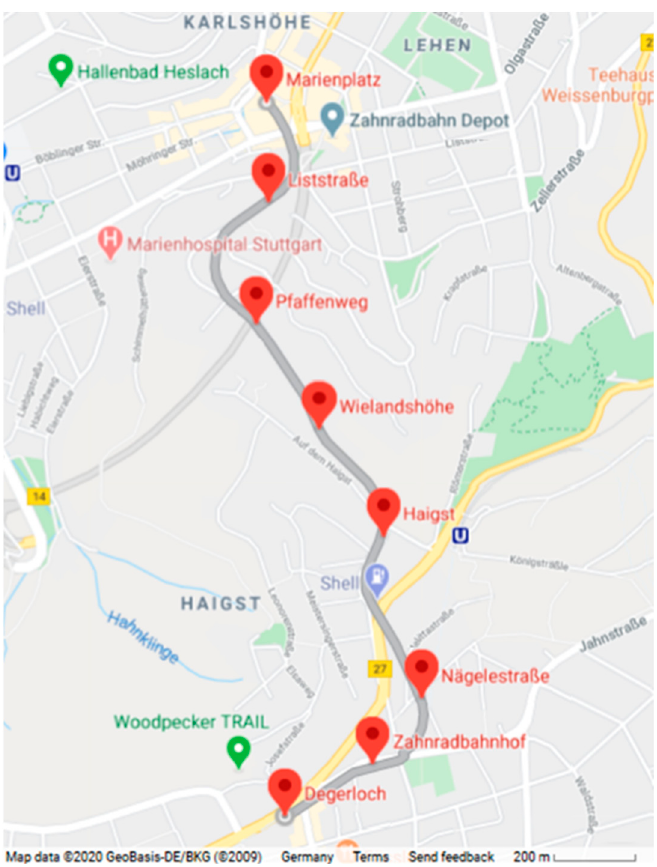
Figure 1. Route map of the rack railway with the stations highlighted with red pins.